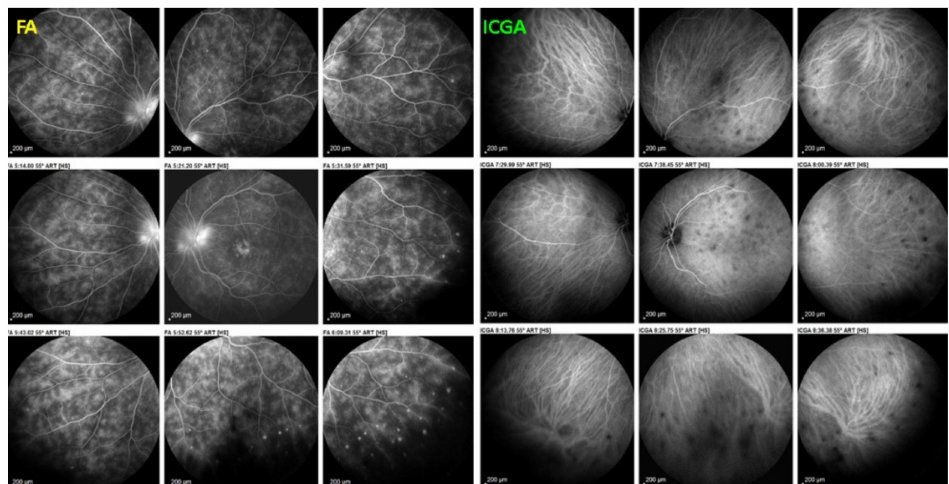
Figure 52. FA and ICGA findings in sarcoidosis chorioretinitis (left eye). FA shows diffuse retinal vasculitis of large and small vessels, papillitis (hyperfluorescent disc), and cystoid macular oedema. ICGA shows HDDs randomly scattered and some areas of fuzzy vessels with most choroidal vessels still well delineated.